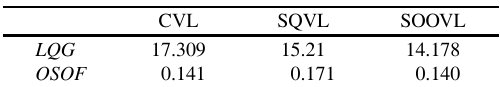
Table 1 Online computation time (sec) for semi-active controllers